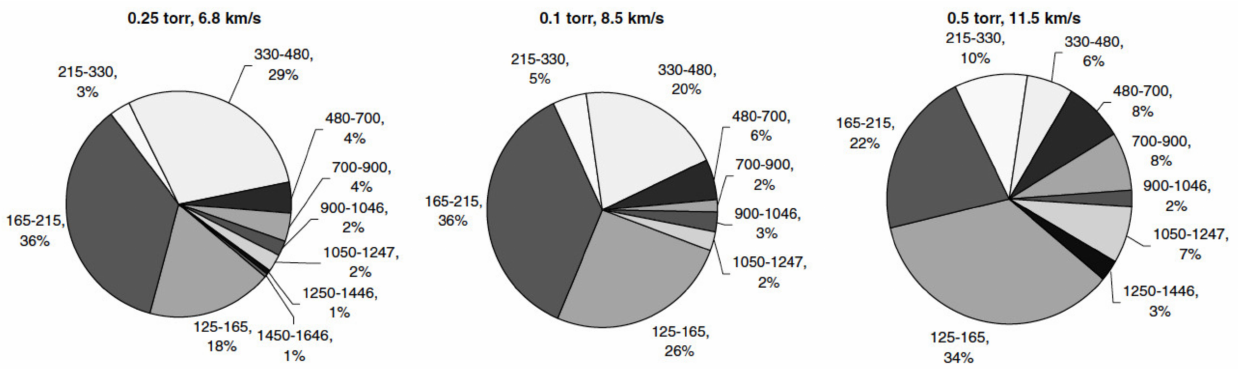
Figure 10. Contributions to the different spectral regions to the total radiance for different Mars (96% CO 2 , 4% N 2 ) and Venus (96.5% CO 2 , 3.5% N 2 ) entry conditions